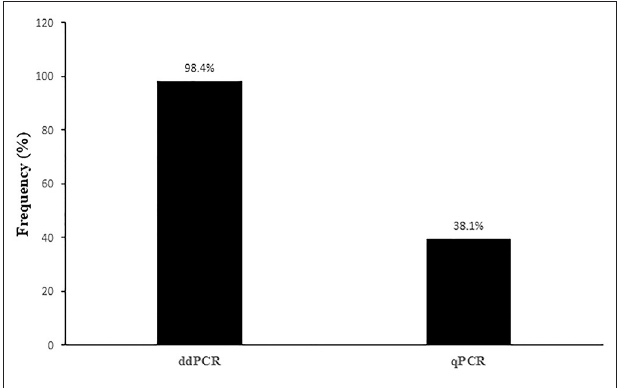
FIGURE 1 | Percentages of positive samples containing OaPV DNA detected via ddPCR and qPCR methods.